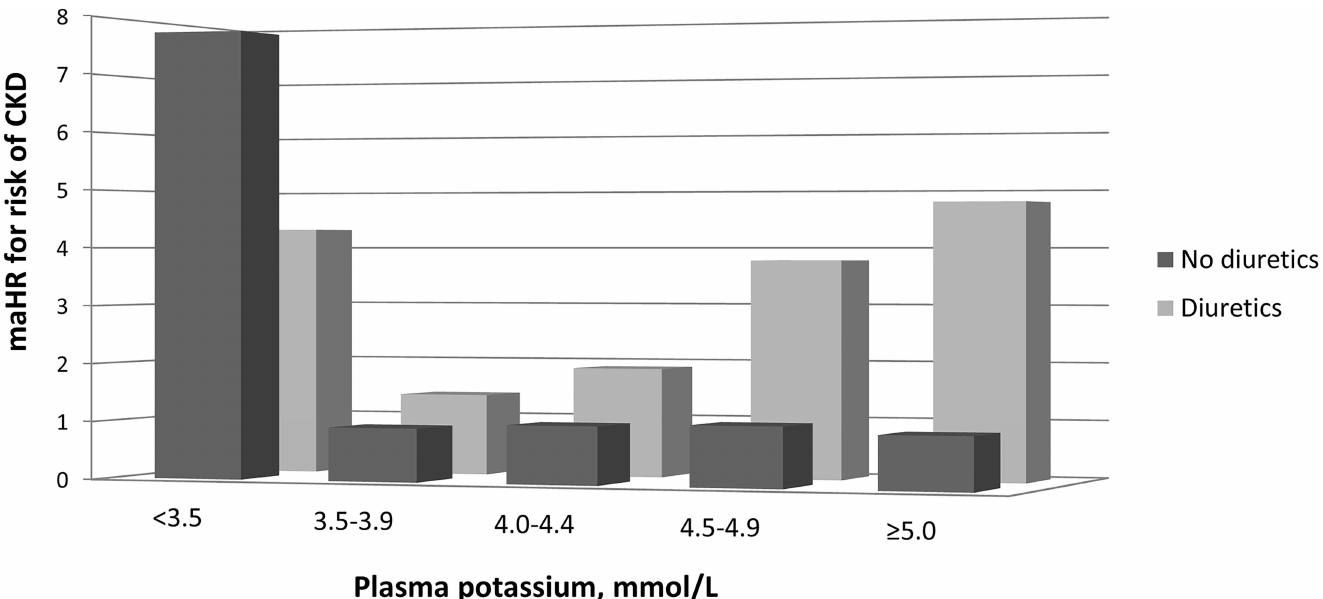
Fig 2. Association of plasma potassium with risk of developing chronic kidney disease stratified by use of diuretics in 5,130 participants of the Prevention of Renal and Vascular End-Stage Disease(PREVEND) study. Hazard ratios were calculatedwith Cox proportional hazardsregression models and were adjusted for age, sex, height, weight, eGFR, and urinary potassium excretion. The category plasma potassium 4.0–4.4 mmol/L and no diuretics was set as reference. Abbreviations: CKD, chronickidney disease;eGFR, estimated glomerularfiltration rate; maHR, multivariable-adjusted